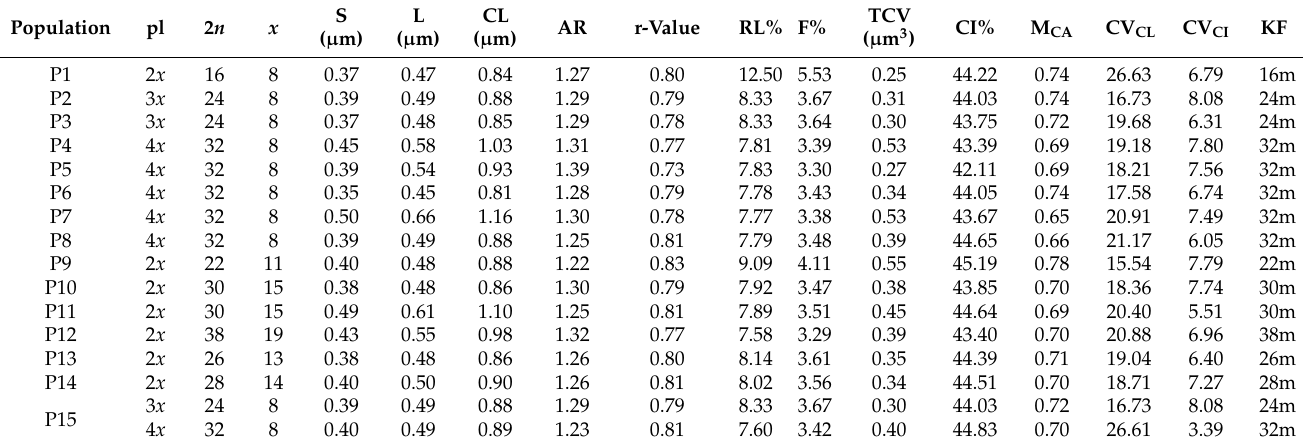
Table 1. Somatic chromosome number, ploidy level, basic chromosome number and mean chromo- somal and karyological parameters of 15 Hypericum perforatum populations. S: small arm length; L: long arm length; CL: total length of chromosome; AR: arm ratio; RL: relative length of chromosome; F%: form percentage of chromosome; TCV: total chromosome volume; CI%: centromeric index; M CA : mean centromeric asymmetry; CV CL : interchromosomal asymmetry; CV CI : coefficient of variation